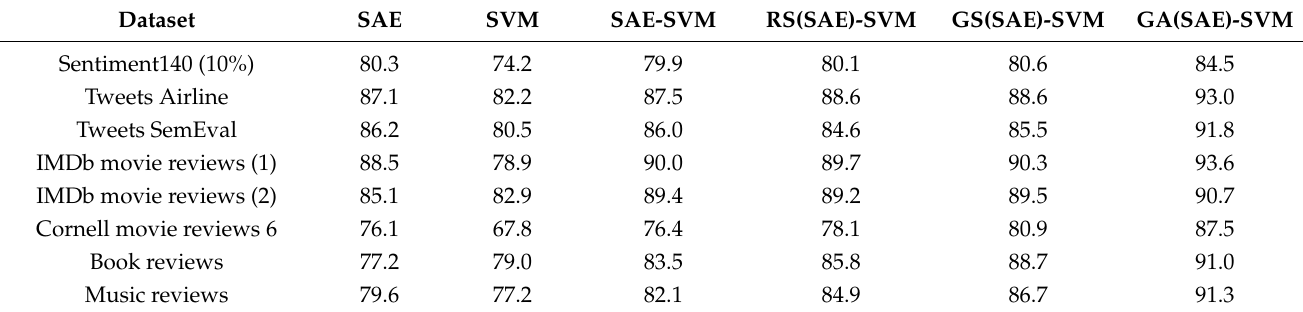
Table 7. Accuracy comparison for different types of datasets.